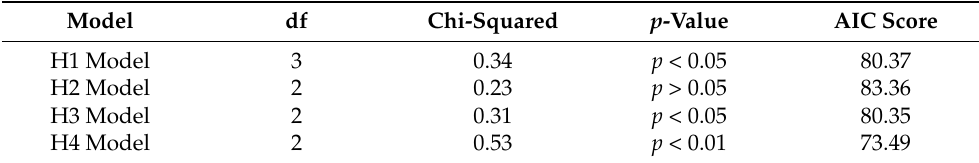
Figure 4. The mean and standard error of maximum watershed elevation ( A ), July temperatures ( B ), and the percentage of very fine soils in the watershed ( C ) for sites where Allocapnia mohri was present and absent. Table 4. Results from the Multiple Logistic Regression (MLR) showing values for p and chi-square, then Akaike Information Criterion (AIC) ranking for four hypotheses related to Allocapnia mohri presence/absence.